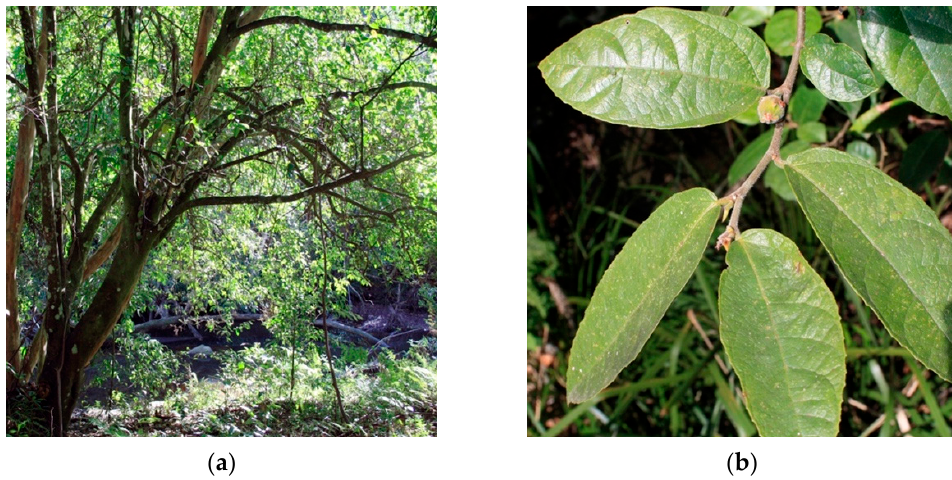
Figure 1. ( a ) A small multitrunked Ficus coronata of around 7 m tall, Royal National Park, NSW, Australia; ( b ) Sandpaper-like foliage and young figs. Photography by B.C. Wilde.